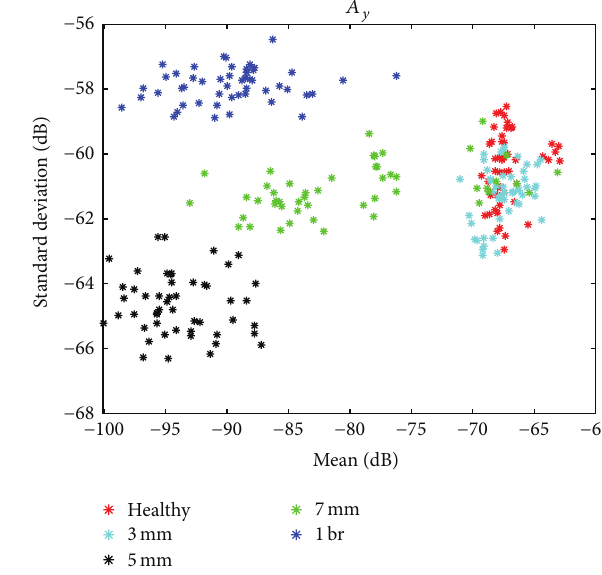
Figure 16: Full-load condition analysis, 𝐴 𝑦 -axis.